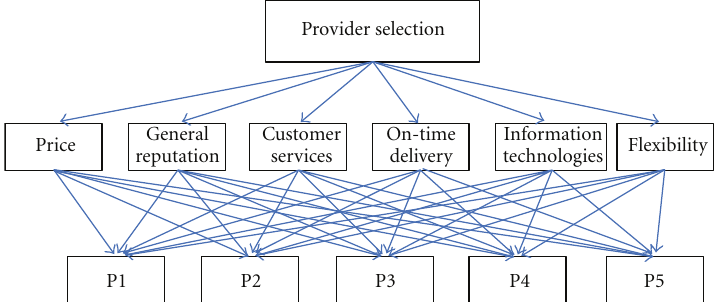
Figure 2: Hierarchical structure of the model.